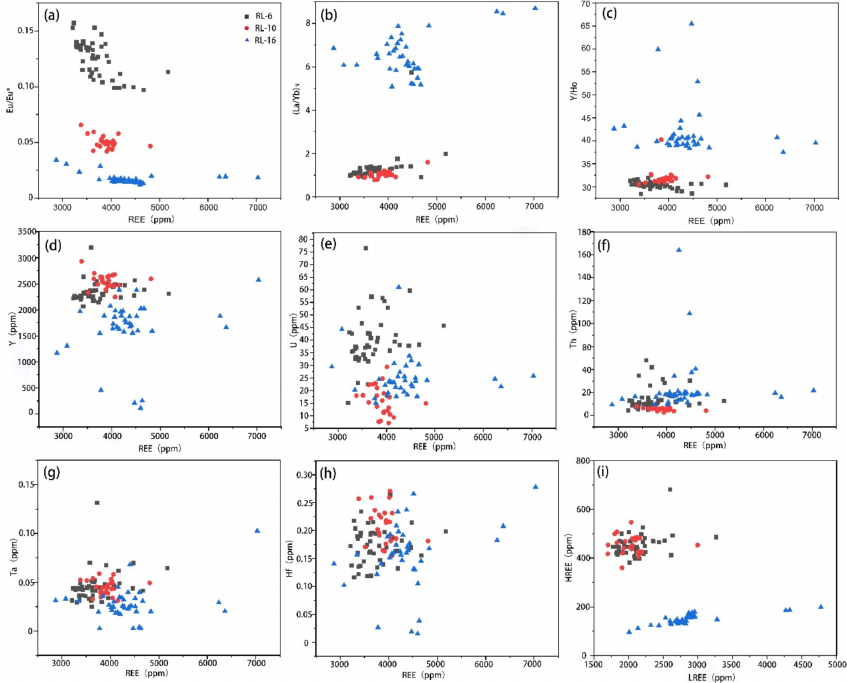
Figure 8. Scatter diagram of apatite in the RL-6, RL-10, and RL-16 samples: ( a ) REE vs. Eu/Eu*; ( b ) REE vs. (La/Yb) N ; ( c ) REE vs. Y/Ho; ( d ) REE vs. Y; ( e ) REE vs. U; ( f ) REE vs. Th; ( g ) REE vs. Ta; ( h ) REE vs. Hf; and ( i ) LREE vs.